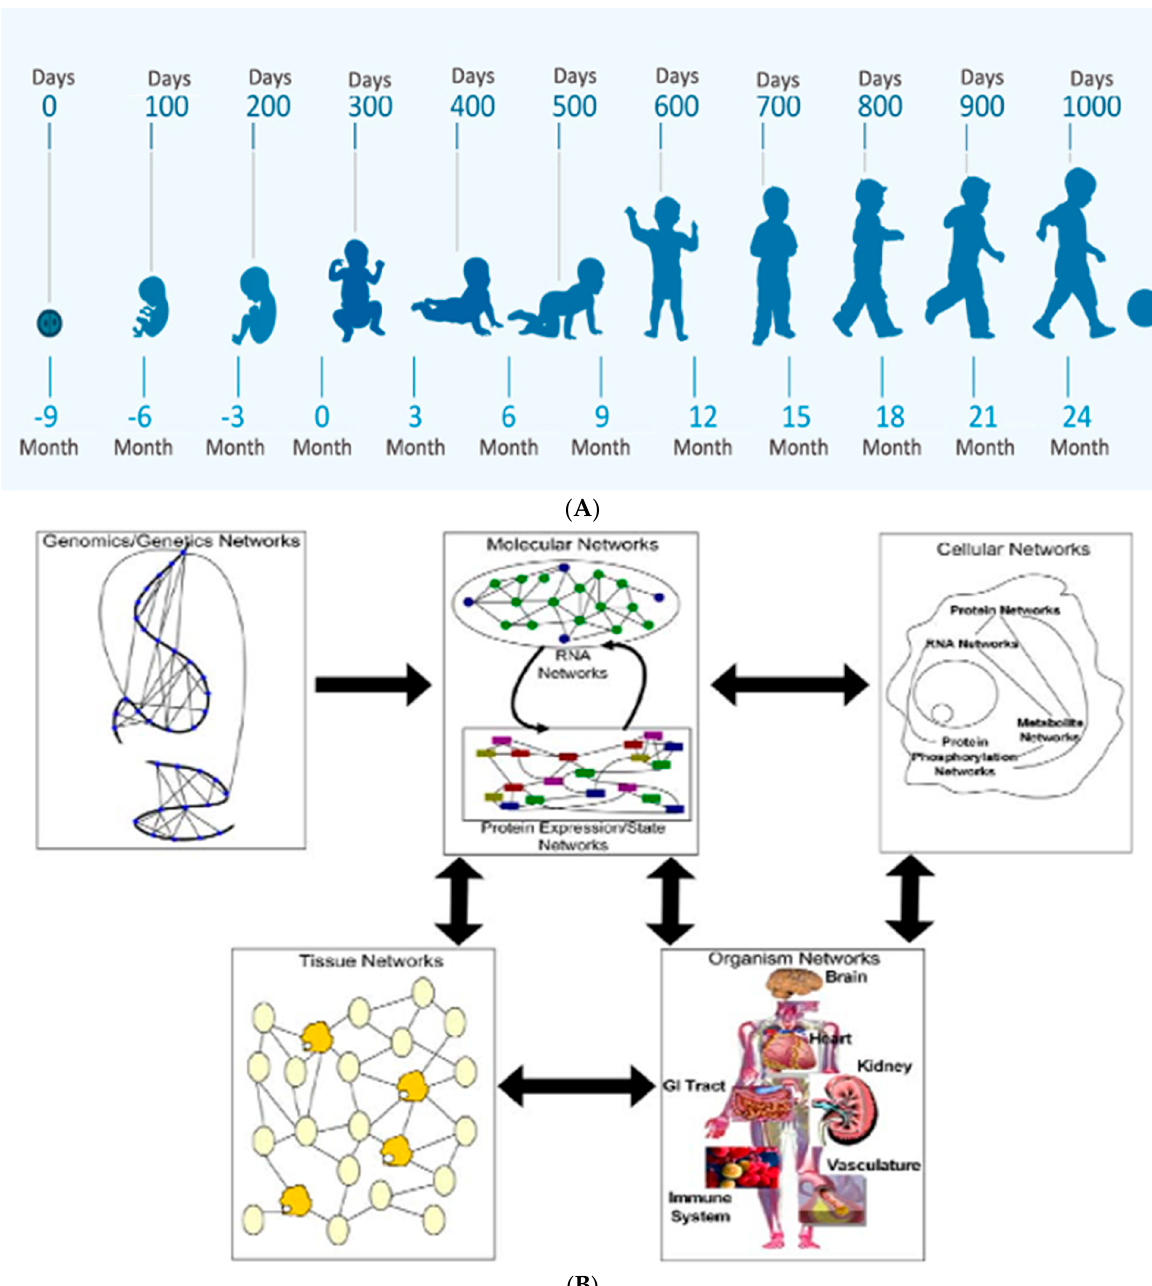
Figure 1. The horizontal/vertical diagnostic process across maturing phenotypes during the first 1000 days: ( A ) This horizontal perspective over the first 1000 days starts at conception through two years of age from embryo to the young child, as depicted by this WHO figure. ( B ) The flow of information across biological systems through a hierarchy of networks depicts the vertical diagnostic process. Successive panels highlight the interactions between different networks that comprise a biological system. Genomic networks depict interactions between DNA sequences which may result in a longer range, as well as more short-term changes, that alter chromosome structures to modulate gene activity These interactions also promote synergistic effects on higher-order phenotypes. Genomics networks in turn subserve molecular networks comprised of RNA, protein, metabolites, and other molecules within the system. Molecular networks are components within cellular networks in which complex interactions between these networks result in the complex phenotypes that define living systems. Tissue networks comprise cellular networks which are influenced by molecular and genomics networks. Organism networks then comprise tissue networks that define the component cellular and molecular networks. Disease states are complex phenotypes that emerge from this complex web of interacting networks, given disrupted genetic and environmental interactions to the living system (Sieberts 2007).